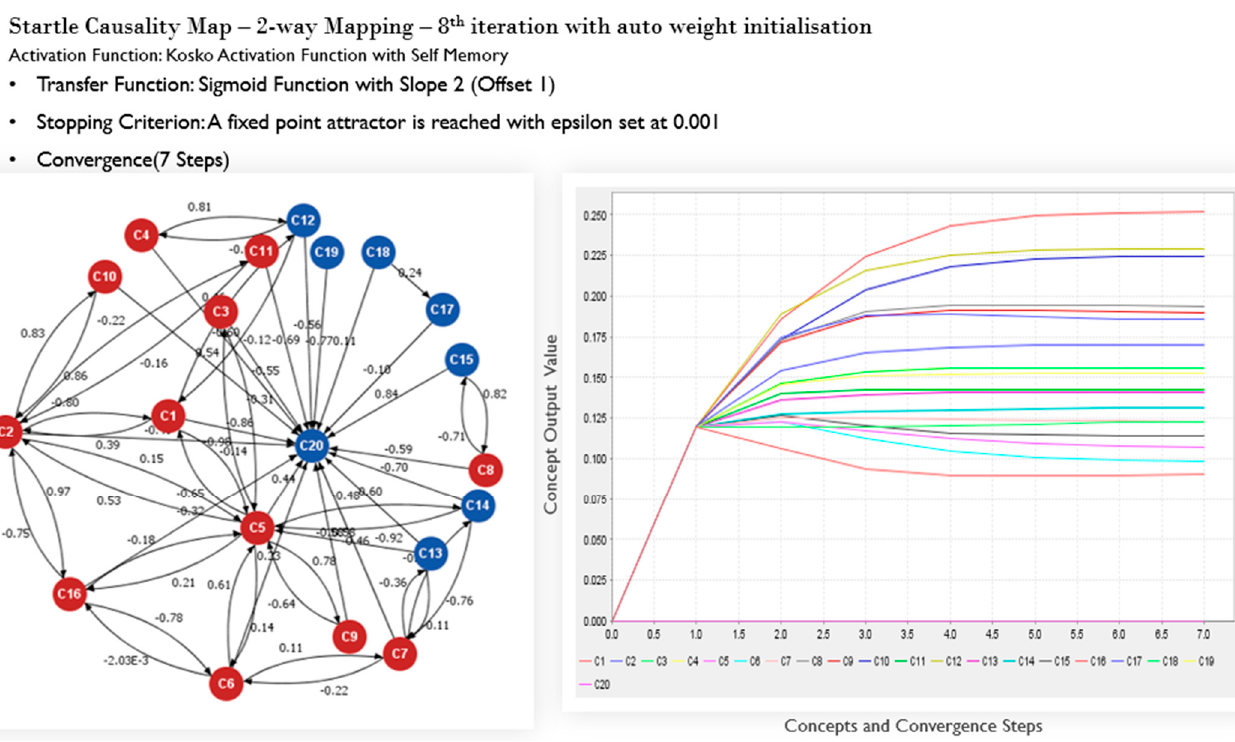
Figure 5. Initial mapping and associated convergence output plot with the stopping criterion adjusted to test the output behavior.